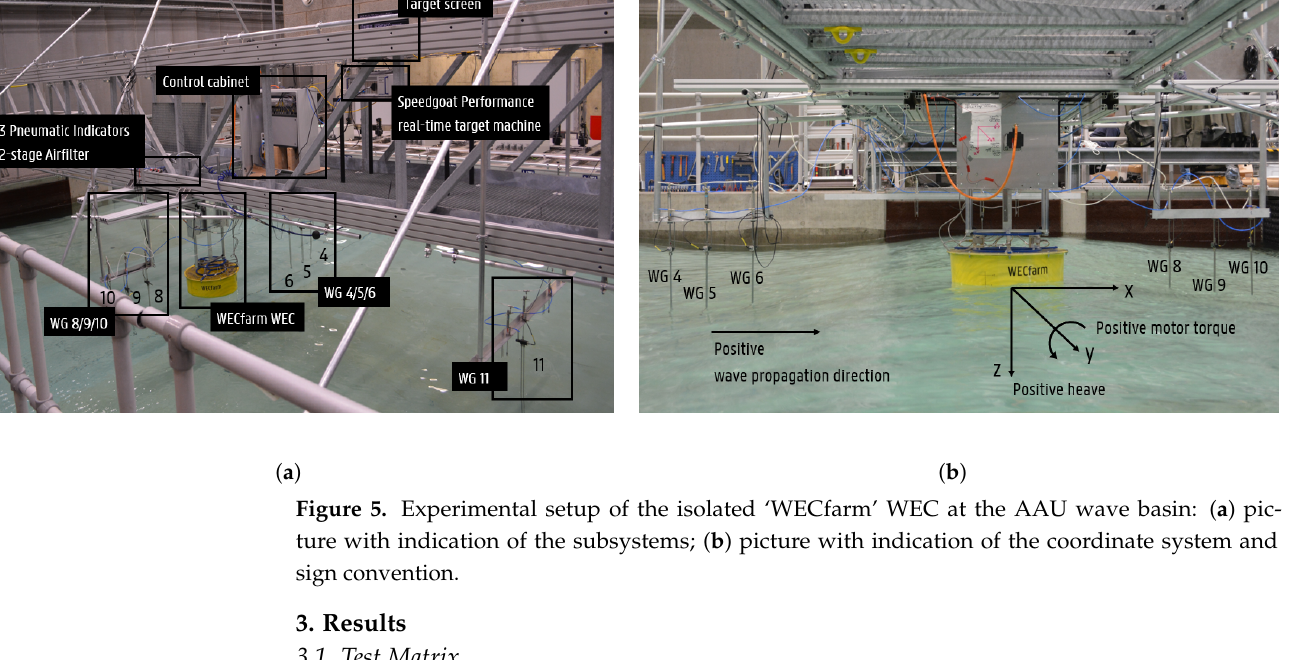
Figure 4. Experimental setup of the isolated ‘WECfarm’ WEC at the AAU wave basin: ( a ) wave basin planview layout with dimensions in meters; ( b ) bird’s-eye perspective picture towards the wave paddles.